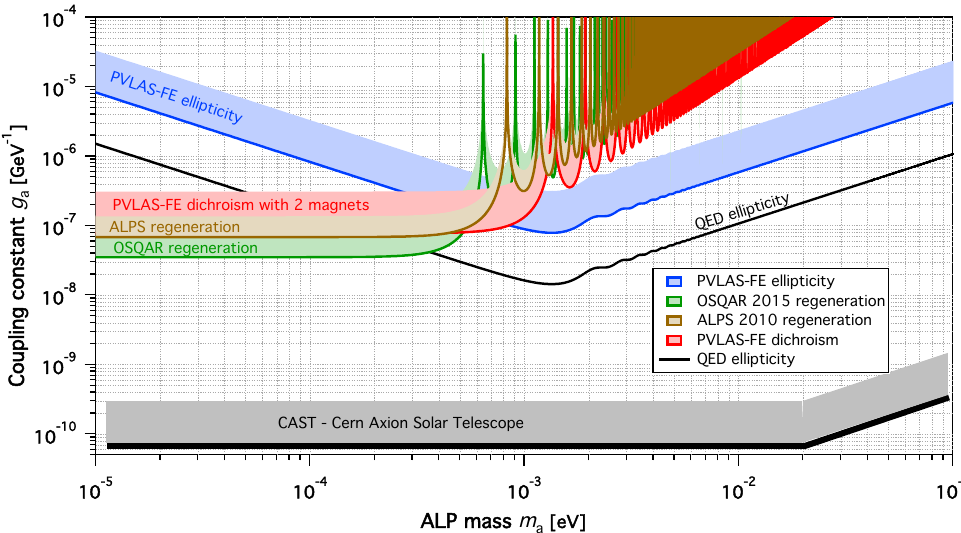
Figure 18. Laboratory limits on the existence of ALPs particles at 95% c.l. The shaded regions of the graph are excluded. Superimposed on the plot is the ellipticity corresponding to effect of QED vacuum magnetic birefringence. The figure also shows the measurements by the OSQAR [51] and the ALPS [50] collaborations. For comparison, the latest limits by CAST [86] are also